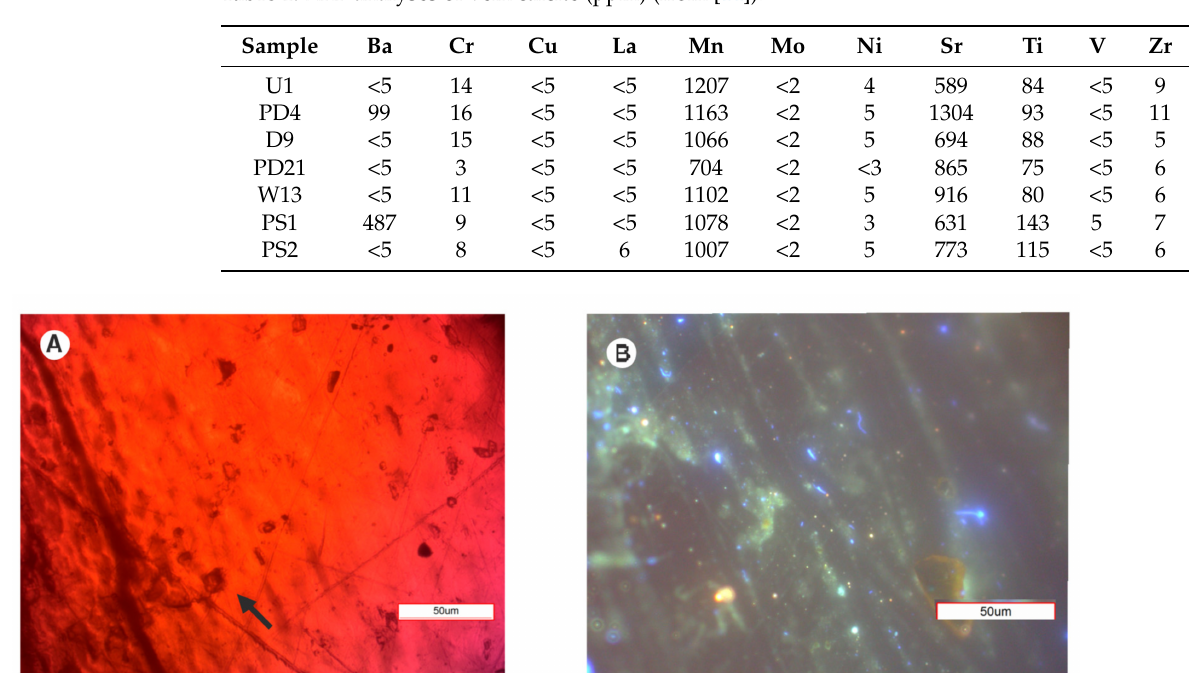
Table 1. XRF analyses of vein calcite (ppm) (from [14]).